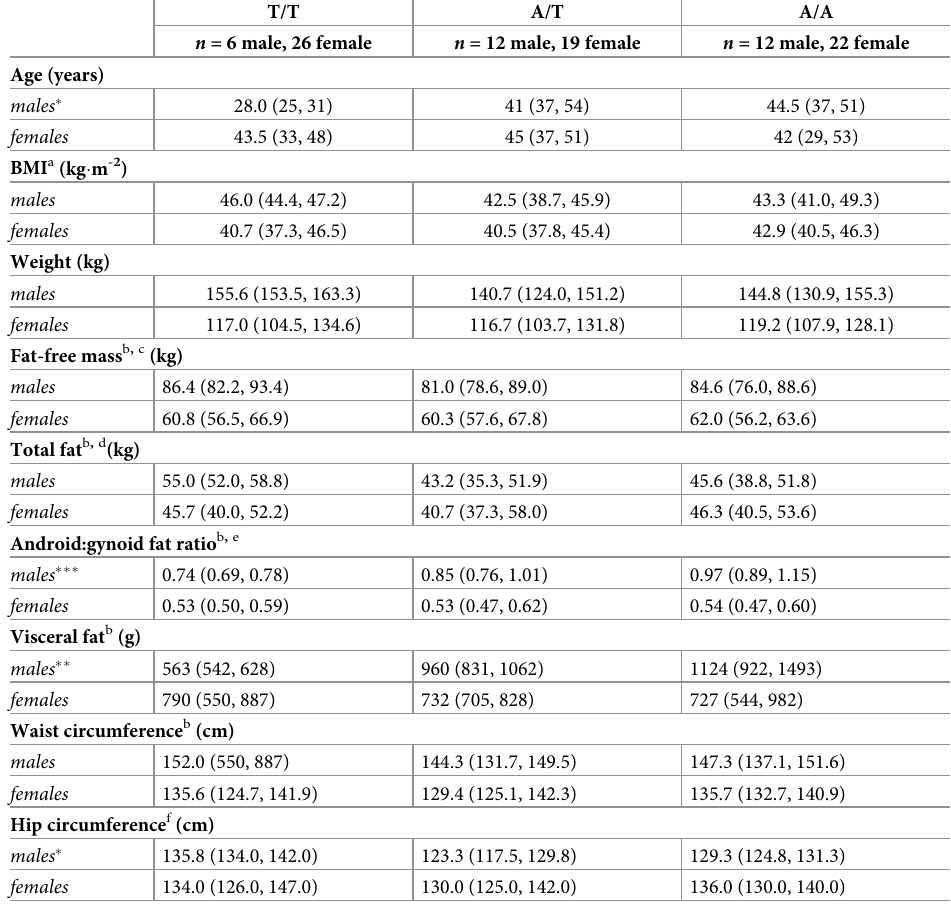
Table 1. Anthropometric and body composition measures by sex and genotype group, n = 97. T/T A/T